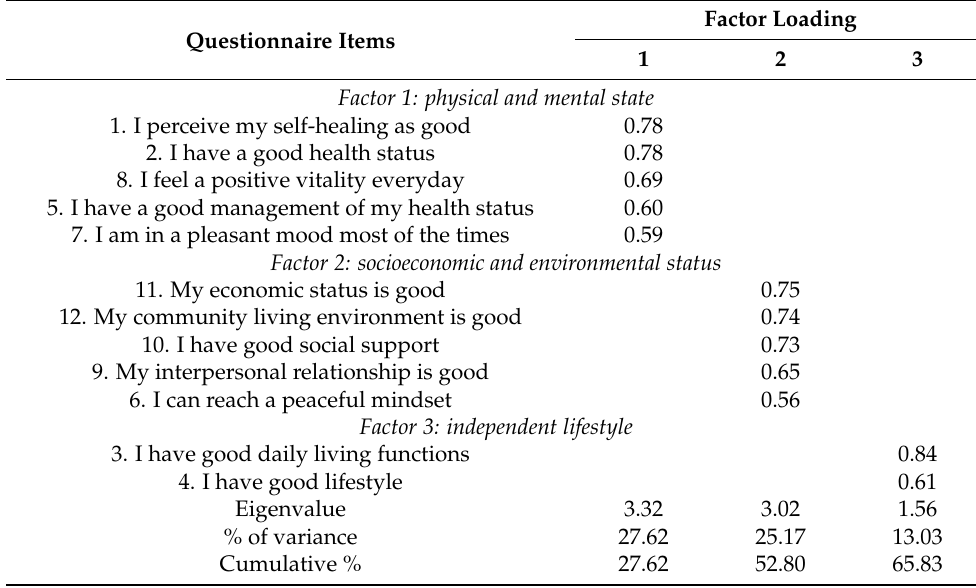
Table 3. Rotated factors for principal components analysis of SHAS.